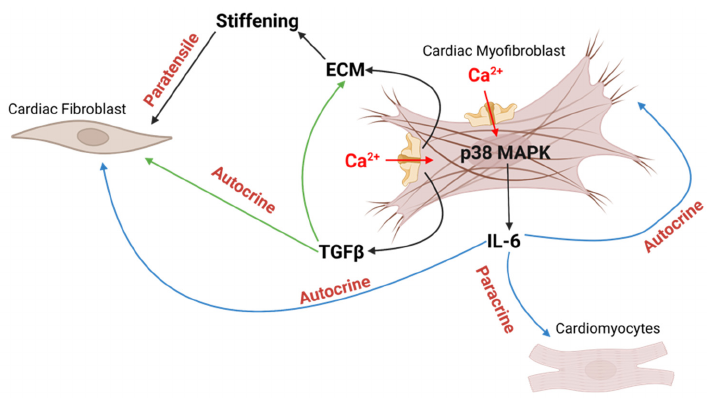
Figure 3. Piezo1-induced autocrine, paracrine, and paratensile effectors in activated fibroblasts. Increased Piezo1 activity can activate the p38 MAPK pathway with enhanced IL-6 secretion. IL-6 acts as a paracrine effector on cardiomyocytes, as well as an autocrine effector for fibroblasts and myofibroblasts themselves. Calcium-stimulated ECM synthesis culminates in the activation of new fibroblasts through a paratensile manner. However, Piezo1-stimulated TGF- β activation enhances ECM synthesis and acts not only as an autocrine effector but also as an indirect paratensile one. Created with Biorender.com (accessed on 15 June 2022).